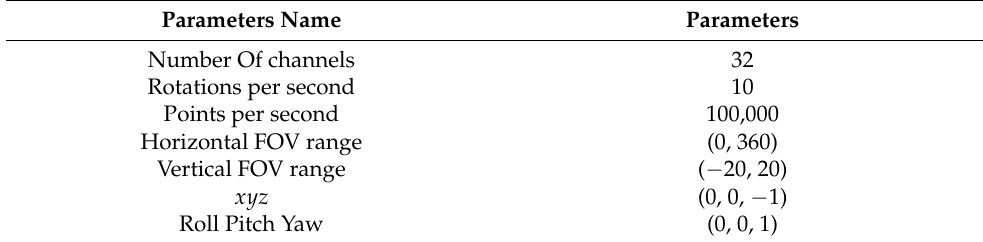
Table 1. The configuration of the simulation lidar in